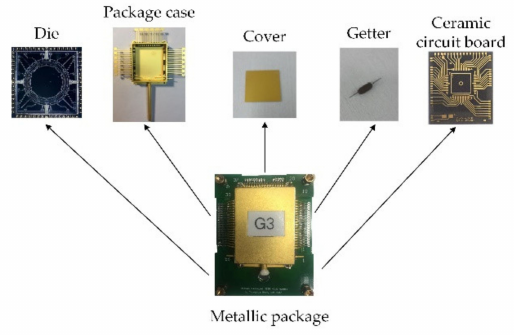
Figure 2. Schematic diagram of the device-level vacuum packaging of the MESG.